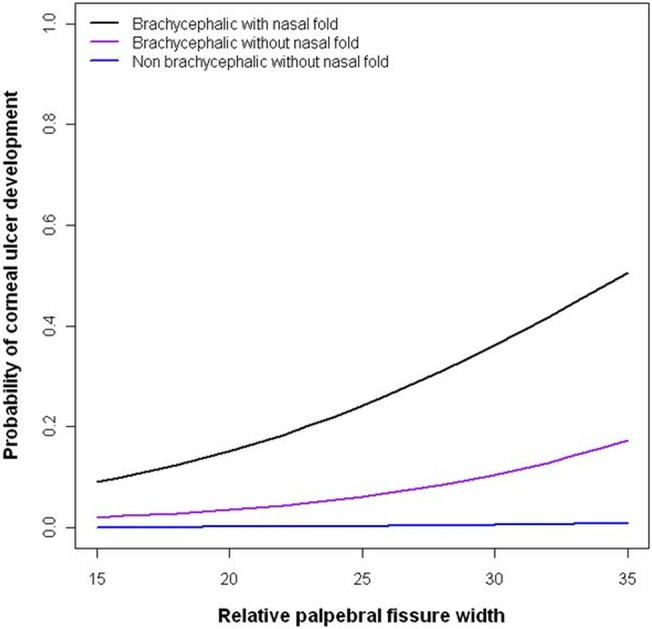
Probability of being affected by a corneal ulcer across the relative palpebral fissure width spectrum.The curves are generated from a generalised linear mixed model that included the presence of a nasal fold, relative palpebral fissure width and craniofacial conformation as predictors for corneal ulceration, and breed as a random effect. Brachycephaly, the presence of a nasal fold, and a relatively wider palpebral fissure all significantly increased the risk of ulceration. Brachycephalic dogs with and without nasal folds, and non brachycephalic dogs without nasal folds are represented, with brachycephalic dogs with skin folds at highest risk throughout the spectrum.